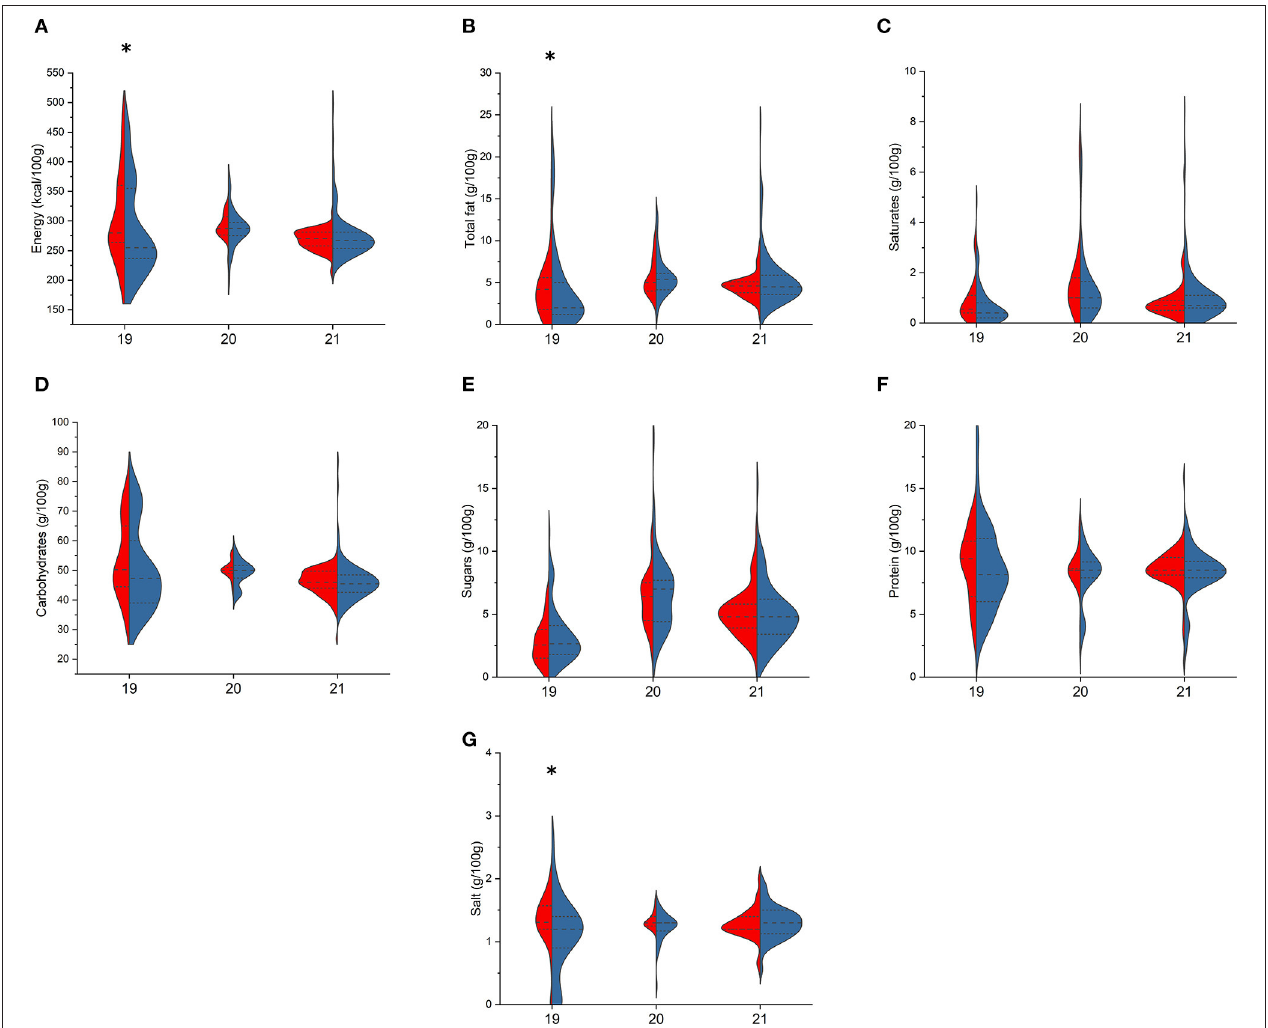
FIGURE 4 | Comparison of energy (A) , total fat (B) , saturates (C) , total carbohydrates (D) , sugars (E) , protein (F) , and salt (G) content in branded (BR, in blue) and private-label (PL, in red) types of breads. 19: loaf bread; 20: rolls; 21: sliced bread. For each type, asterisk indicates significant difference between BR and PL items (Mann–Whitney non-parametric test for two independent samples), p <